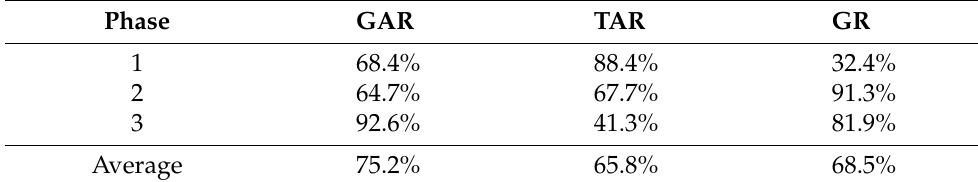
Table 6. Risk identification based on interface